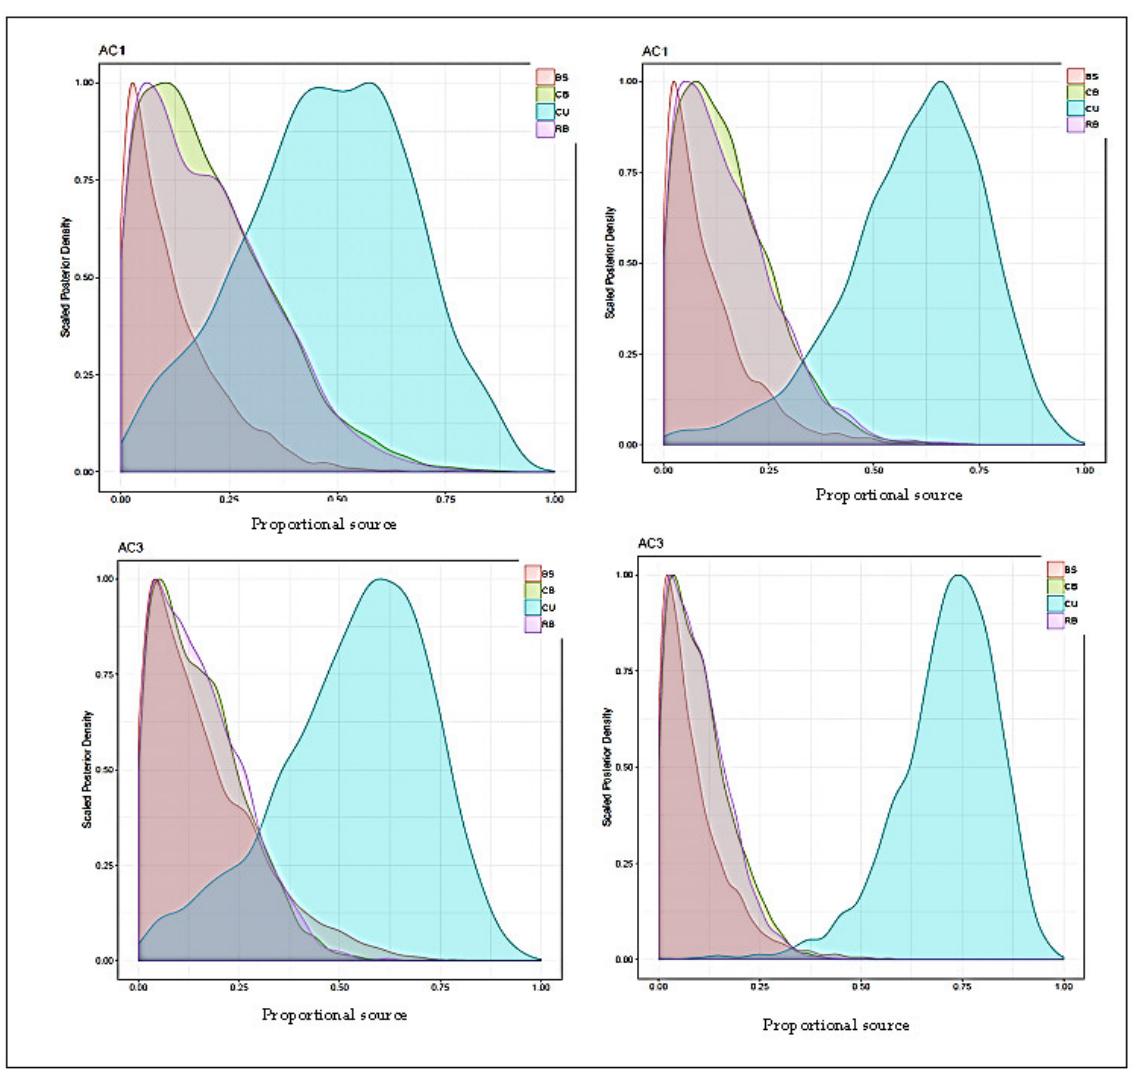
Figure 8. Changing proportional contribution of land use from older to the recent core sections of sediment cores in AC1 and AC3.